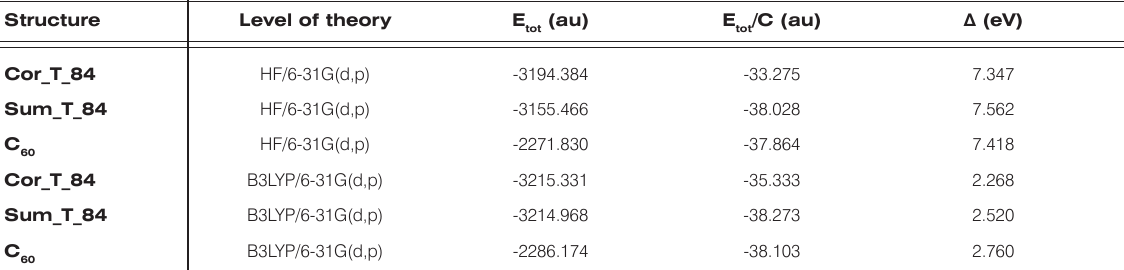
/C and the HOMO-LUMO gaps Δ of the tetrahedrally spanned fullerenes tot fullerene. 60